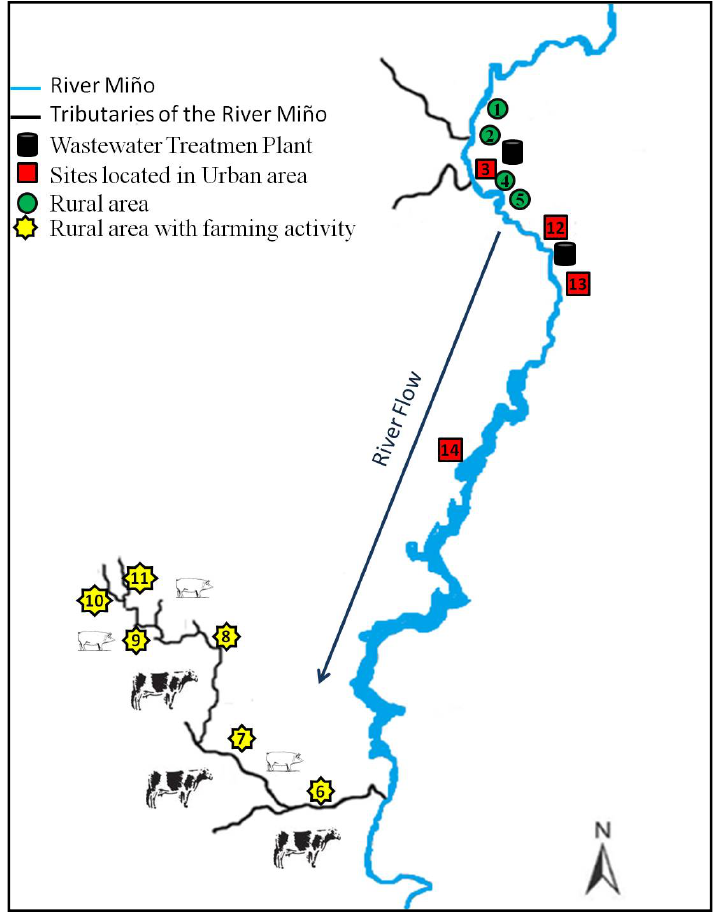
Figure 1. Locations of the sampling sites selected for the monitoring